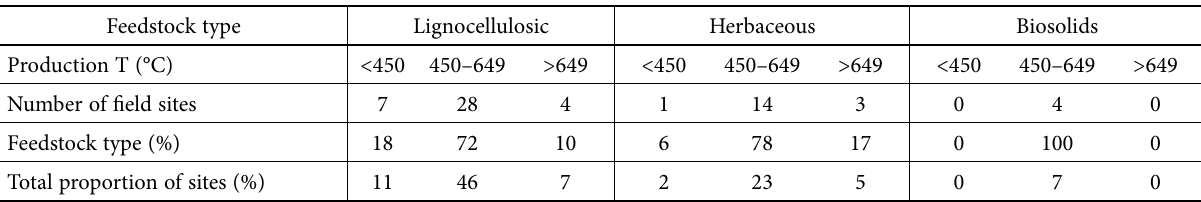
Table 2. Feedstock type and production temperature overview. Lignocellulosic includes woody materials. Herbaceous includes crop residue, green waste and silage. Biosolids include manures, sewage, and liquid organic waste. Carbonisation T refers to